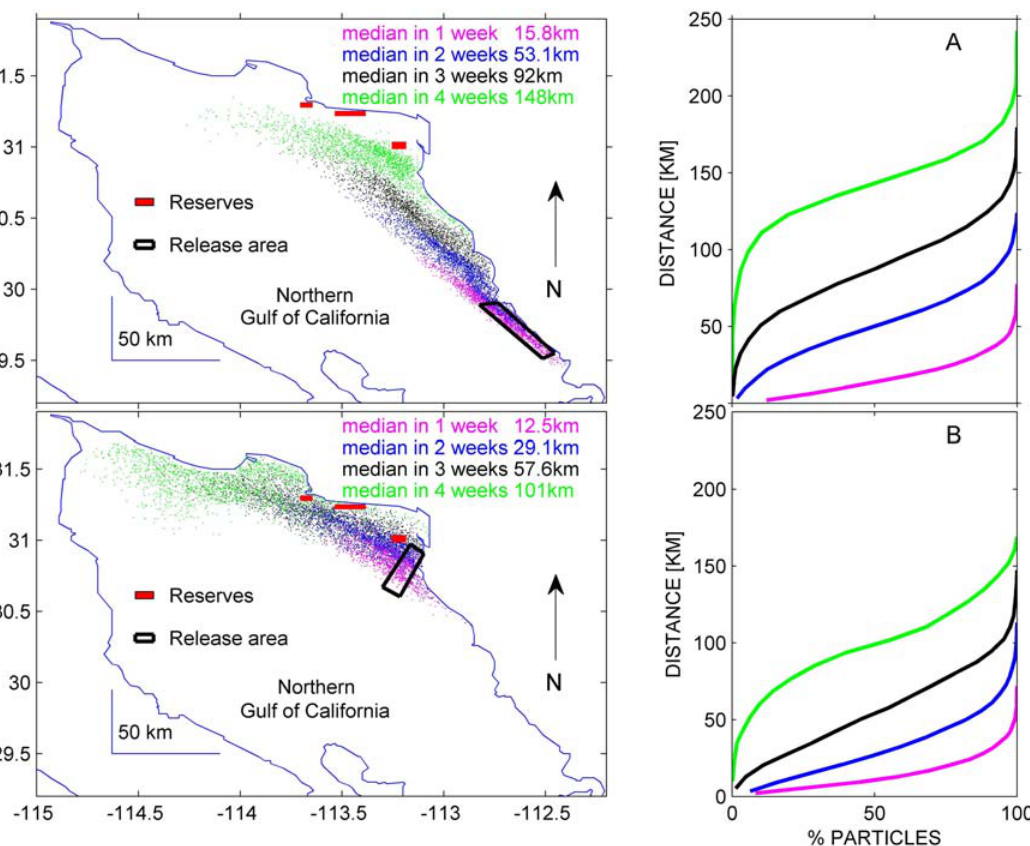
Figure 2. Final position of particles 1–4 weeks after having been released in (a) the nearest rocky reef located south of the marine reserve network, and (b) the network’s southern boundary (San Jorge Island). Panels on right show cumulative percentages of particles as a function of distance 1, 2, 3 and 4 weeks after release.